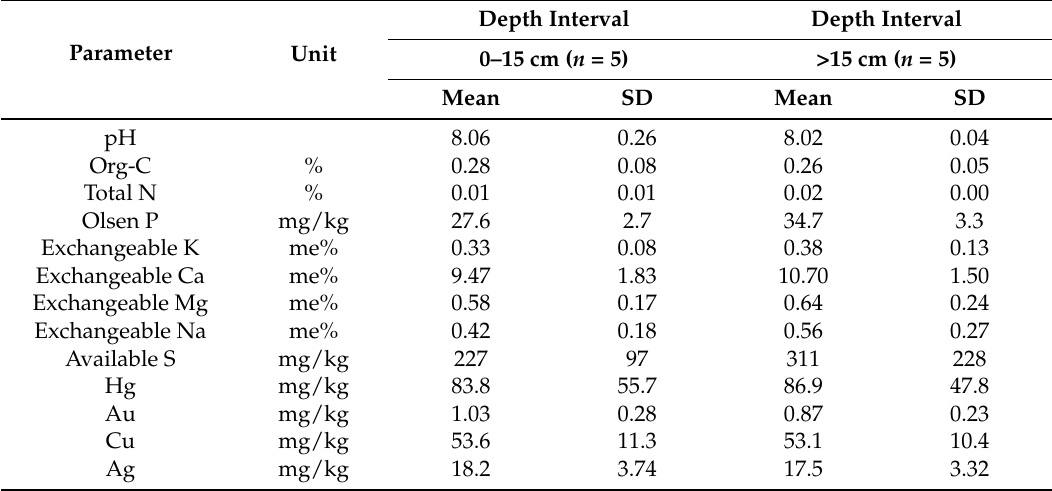
Table 1. Physiochemical properties of the cyanidation tailings used as the substrate for the phytomining demonstration trial. Values and mean and standard deviation of five replicates.